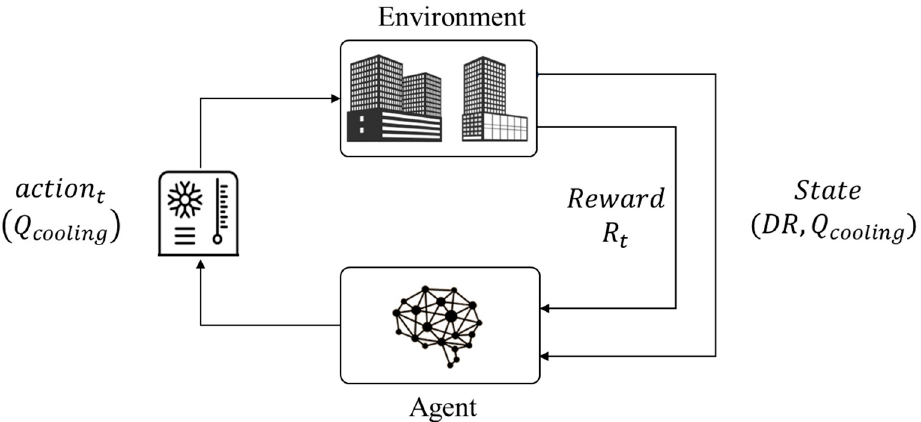
Figure 2. Reinforcement Learning control framework.